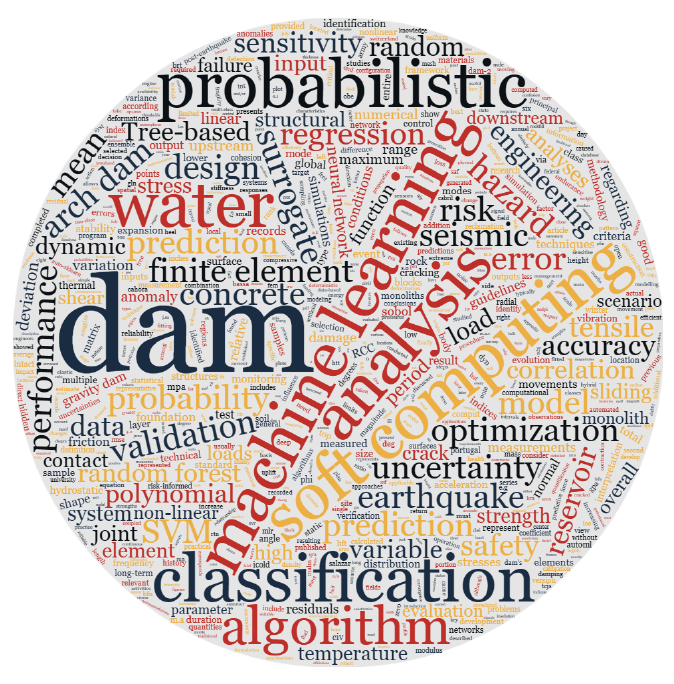
Figure 2. Word cloud from all the accepted papers in this Special Issue journal.